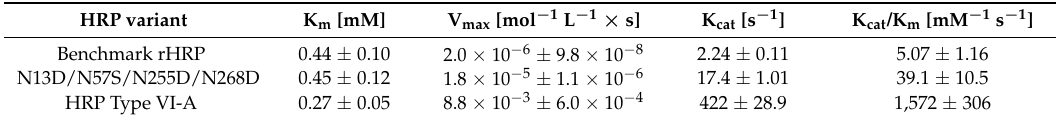
Table 5. Kinetic characteristics of plant HRP, rHRP and N13D/N57S/N255D/N268D with ABTS as reducing substrate in 50 mM KH 2 PO 4 pH 5.